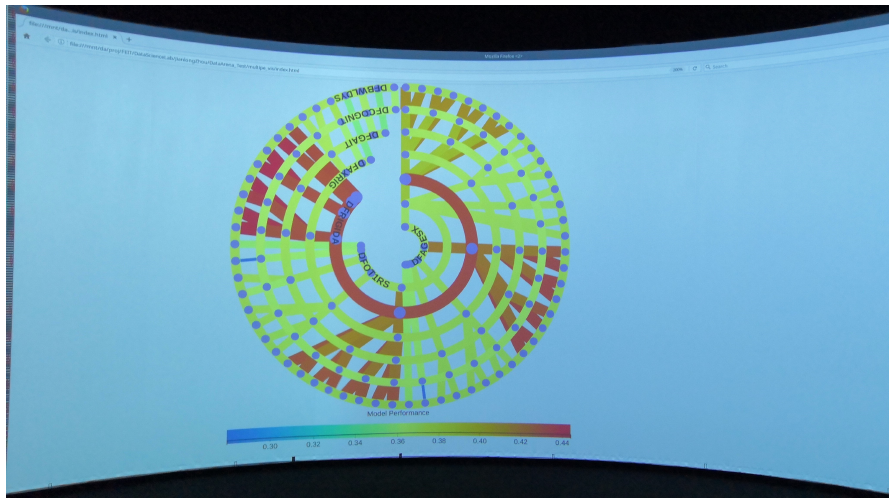
Figure 12. RadialNet displayed in our large scale visualisation